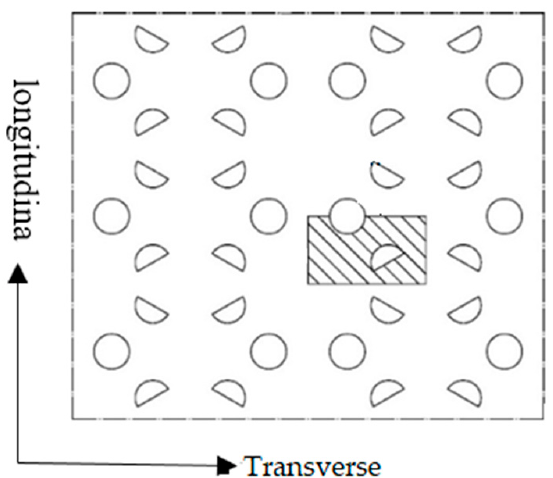
distance in the transverse direction is 5.8 mm. The thickness is 4 mm. The pre-punched arrangement is the same as shown in Figure 5.